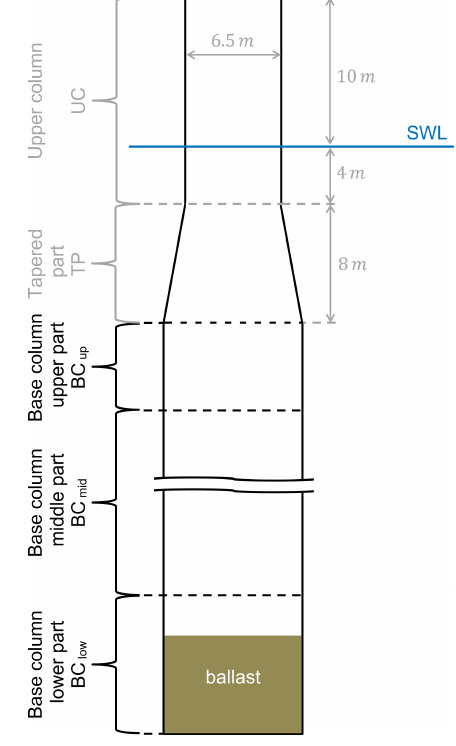
Figure 1. Geometrical definitions of the advanced spar-type float- ing platform.